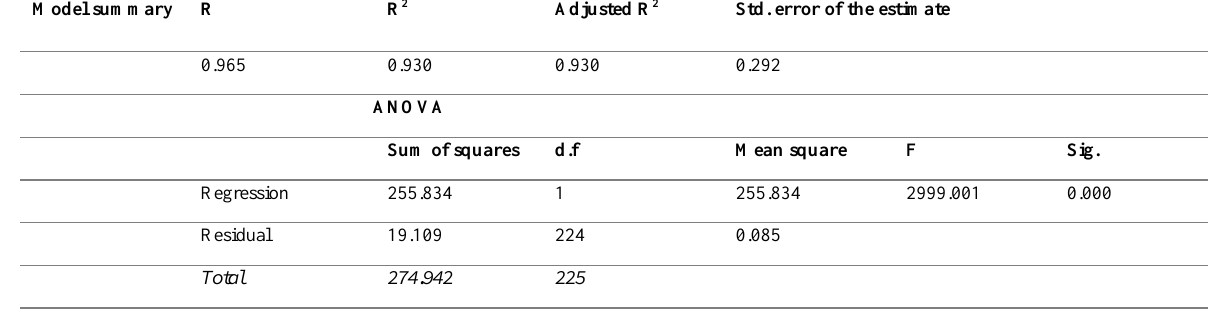
Table 5: Regression output of Utilization of evaluation results on Stakeholder involvement in evaluations Model